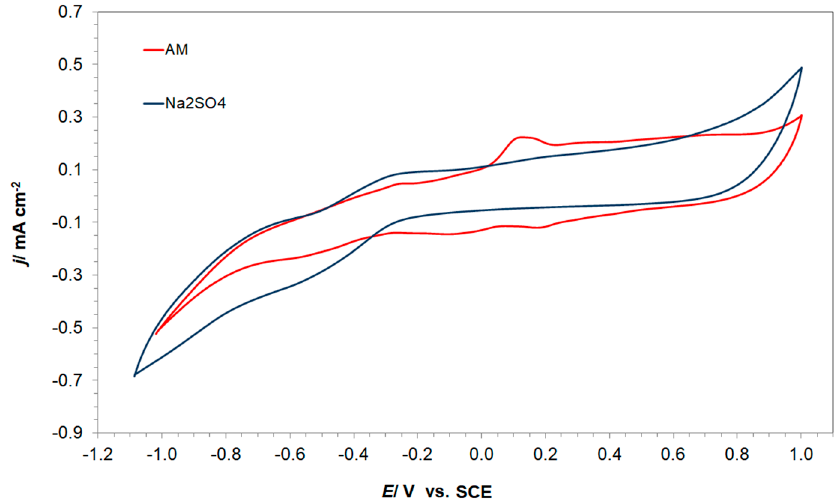
Figure 2. Cyclic voltammetry behavior of the graphite electrode in the absence and presence of AM